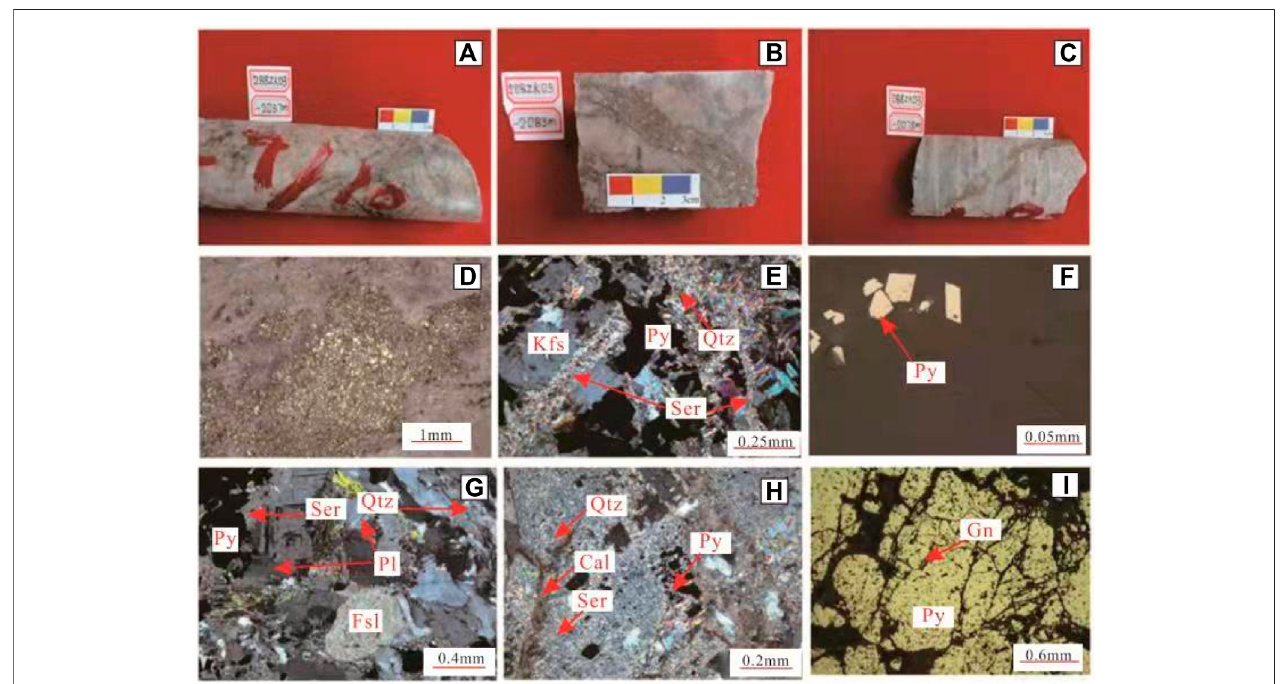
FIGURE 4 | Photos/photomicrographs of the pyrite-sericite-altered cataclastic granitic ore host: (A – B) hand-specimen of sericite-altered cataclastic granite and pyrite veins; (C) pyrite-sericite-altered cataclastic granite; (D) pyrite agglomerates; (E) pyrite with quartz, sericite, and altered K-feldspar residue; (F – G) granular pyrite with quartz (bent by stress) showing undulatory extinction; (H) pyrite metasomatized/corroded along margin, with clear embayment and skeletal structure; (I) pyrite broken with galena fracture in fi ll. Kfs- K-feldspar; Qtz- Quartz; Ser- Sericite; Py- Pyrite; Pl- Plagioclase; Fsl-ferriferous augite; Cal- Calcite; Gn- Galena.